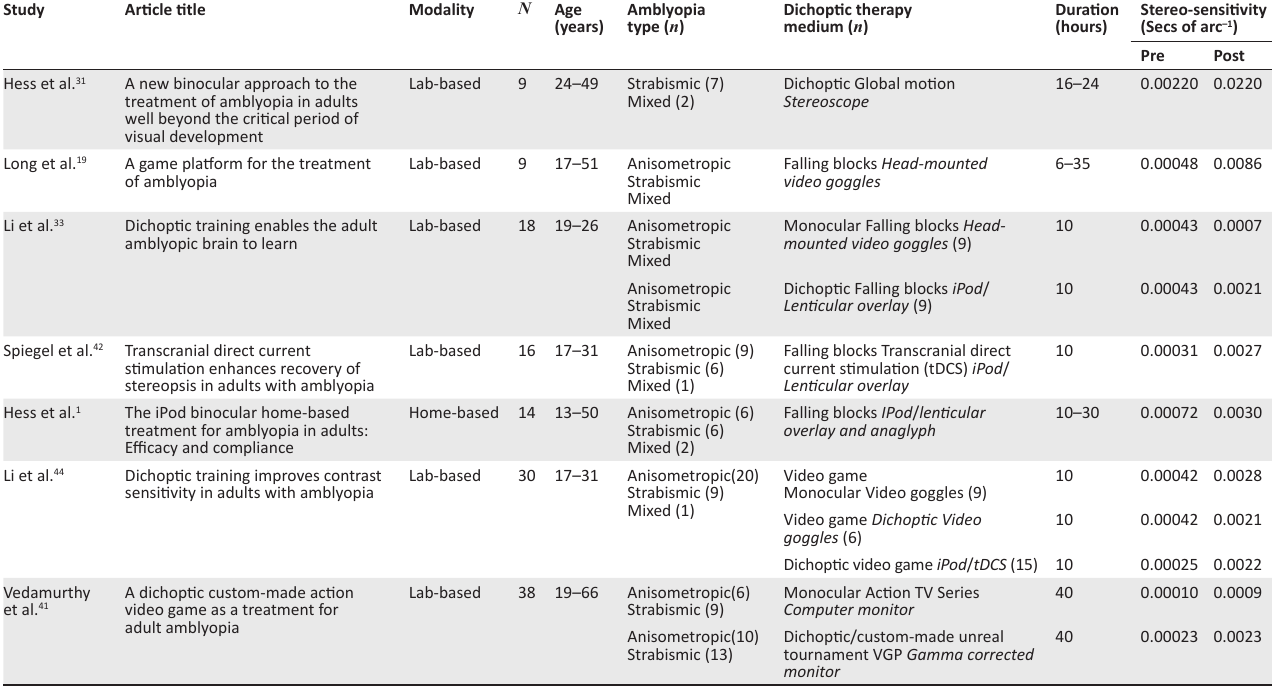
TABLE 2: Dichoptic therapy and stereo-sensitivity improvement in anisometropic, strabismic and mixed amblyopes.